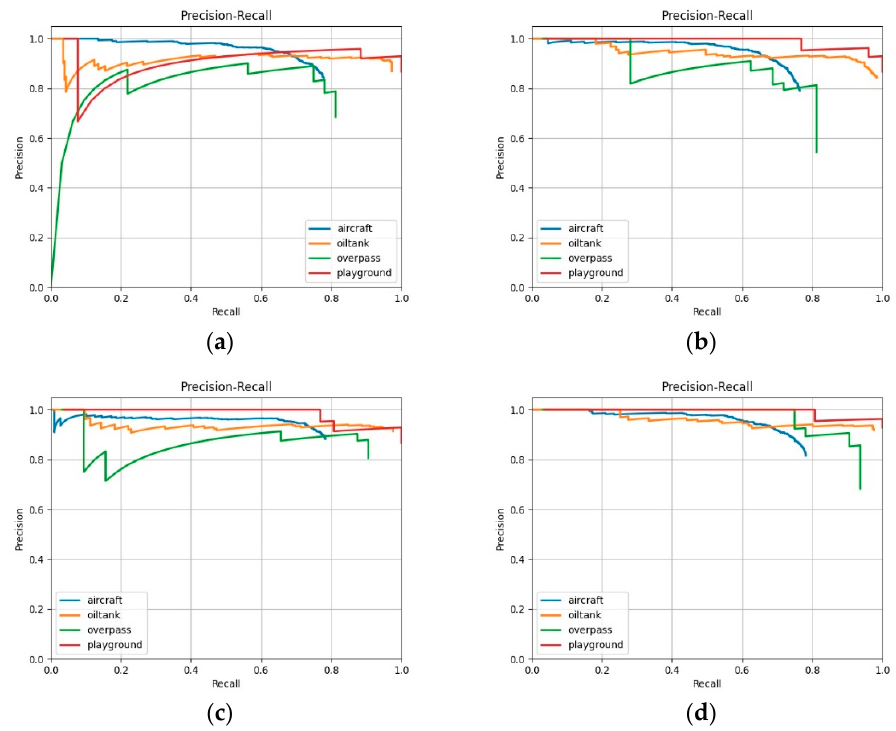
Figure 13. The P-R curves of different frameworks on RSOD-Dataset. ( a ) Def. R-FCN; ( b ) RICA- Det; ( c ) Multi-Scale CNN; ( d ) Multi-stage FEPN. (c) Multi-Scale CNN; (d) Multi-stage